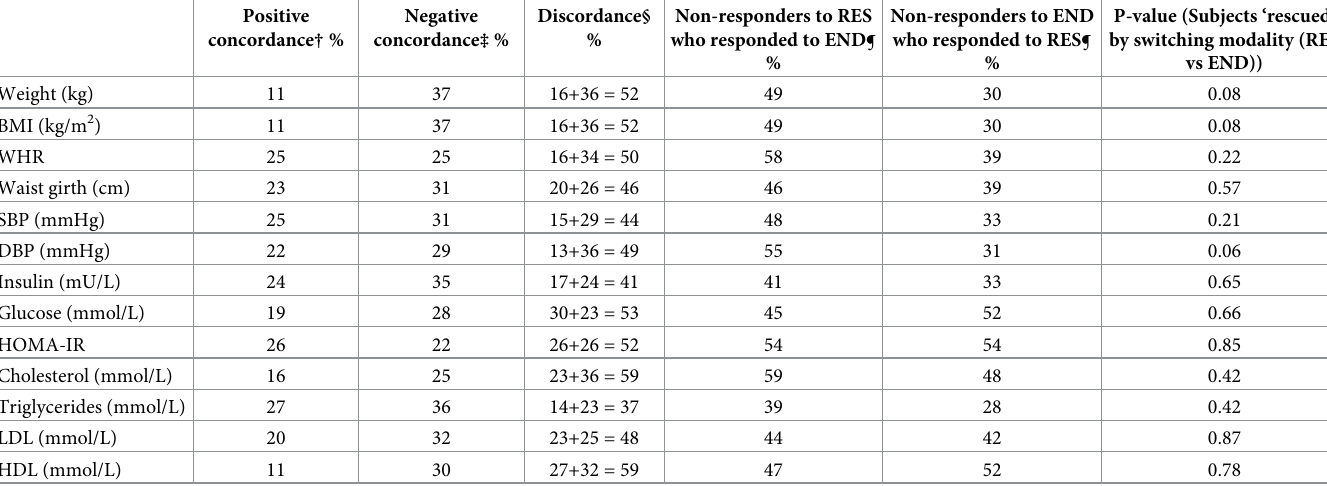
Table 2. Concordance between response to different modes of